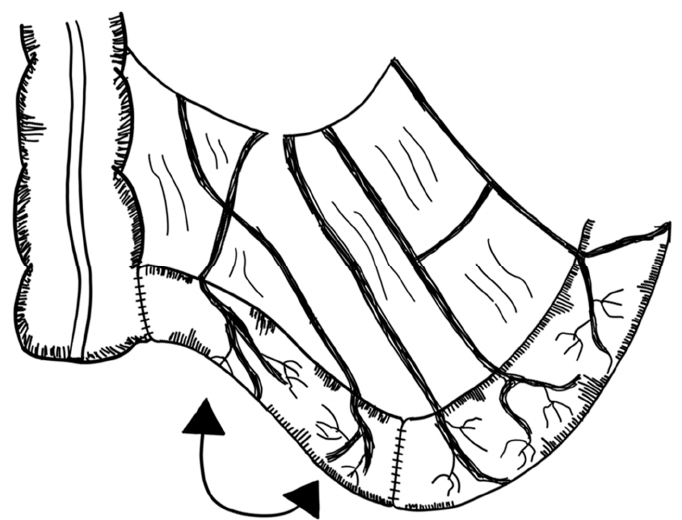
Figure 11. A segment of the small bowel is reversed (indicated by the arrow) and re-anastomosed with a jejuno-colic anastomosis. The reversed segment should measure about 3 cm in children, and it should be located in the distal part of the small bowel, in close proximity with the ileocecal valve. Beyer-Berjot et al. [158].